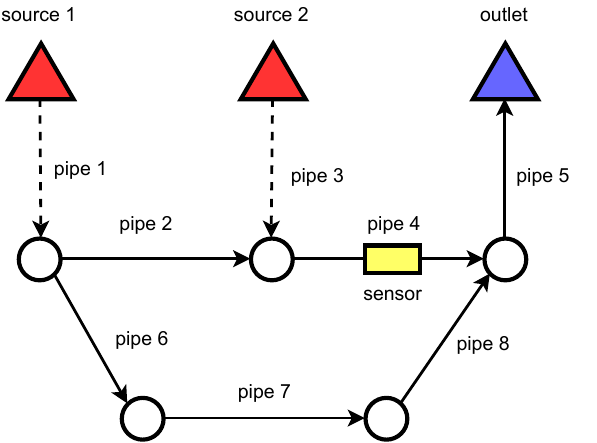
Figure 4. Network coverage. Assuming that V 1 = 2,4,6,7 and V 2 = 4,5, the sensor installed in pipe 4 is enough to cover both sources. Installing it in pipe 5 would cover only the second